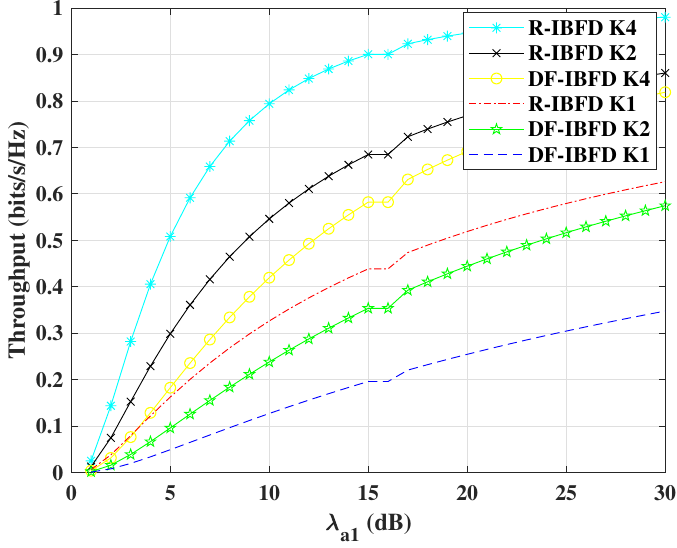
Figure 6. Throughput comparison for Reflective In-Band Full-Duplex (R-IBFD) and Decode-and- Forward IBFD (DF-IBFD) with C th = 1, ζ 12 = ζ 11 = 12 dB, K = 1, 2 and 4 and ζ 1 e is calculated with respect to Rayleigh flat fading and respective